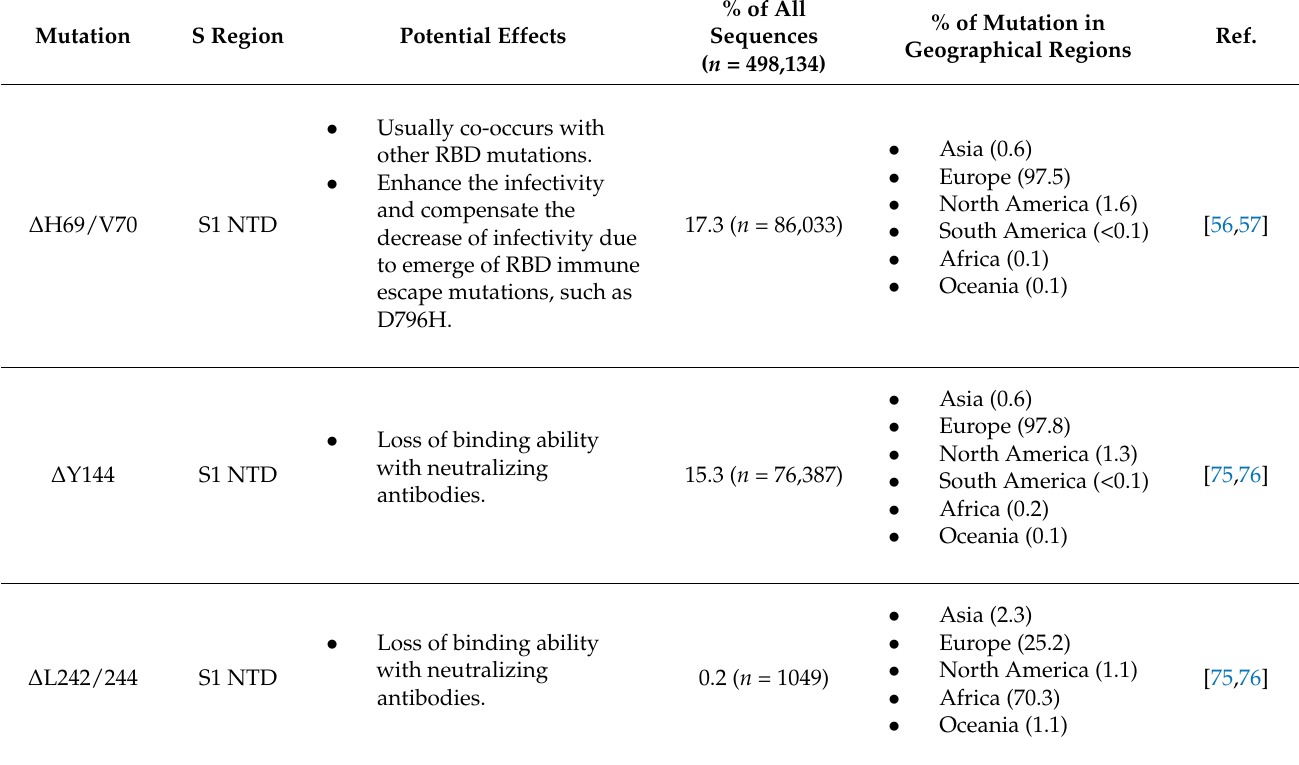
Table 1. Impacts of mutations in S glycoprotein in circulating SARS-CoV-2.